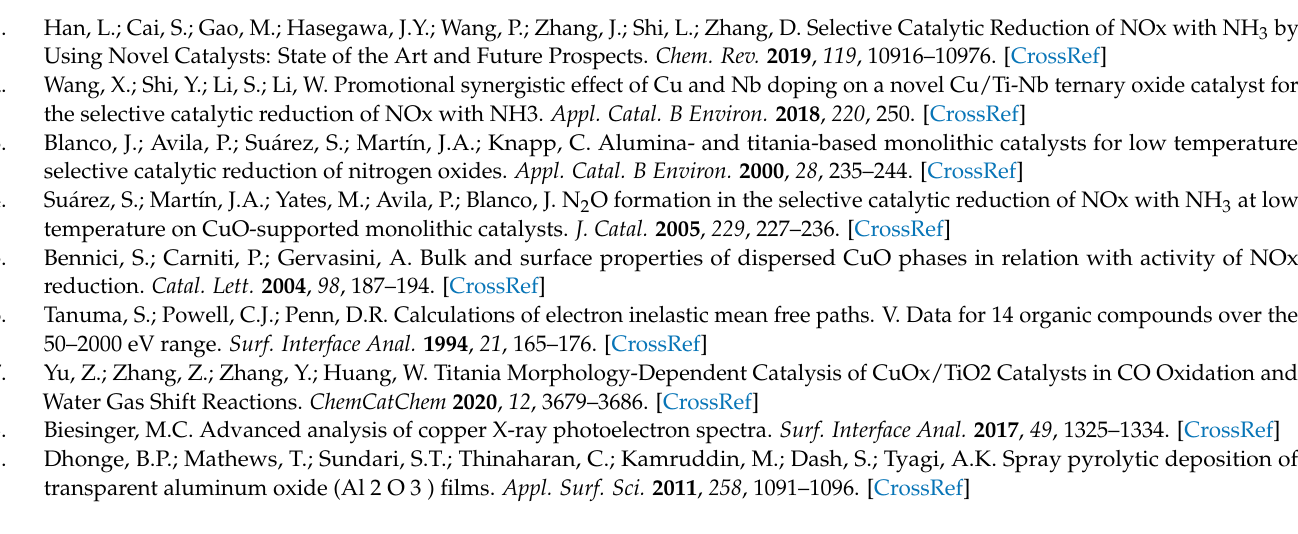
used catalysts Table SB1. XPS C 1s data of fresh catalysts., Table SB2. XPS C 1s data of used catalysts. Figure S1. TG, DTG and DSC curves for titania (A) and Ti 0.9 Al 0.1 (B) precursors., Figure S2. C 1s XPS spectra of fresh (a) and used (b)